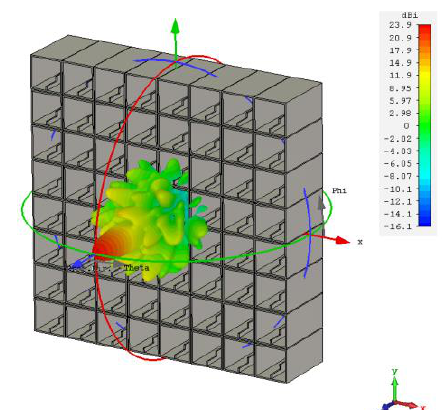
Fig. 1 . Antenna array of circularly polarized waveguide emitters.